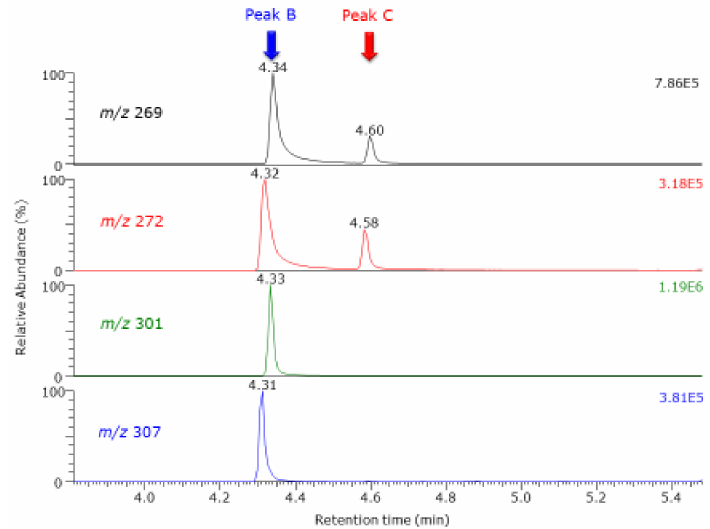
Figure 7. GC-MS chromatograms from the measurement of GSH (1 mM) with deuterium-labeled GSH (1 mM) as the internal standard after esterification and acylation. SIM of m / z 269, m / z 272, m / z 301 and m / z 307 was performed. Peak C eluting at 4.58/4.60 min with m / z 269 and m / z 272 is considered to be pyroglutamate from decomposed/rearranged unlabeled and deuterium-labeled GSH. Oven temperature program TP#1 was used. Peaks B and C refer to Figure 1.